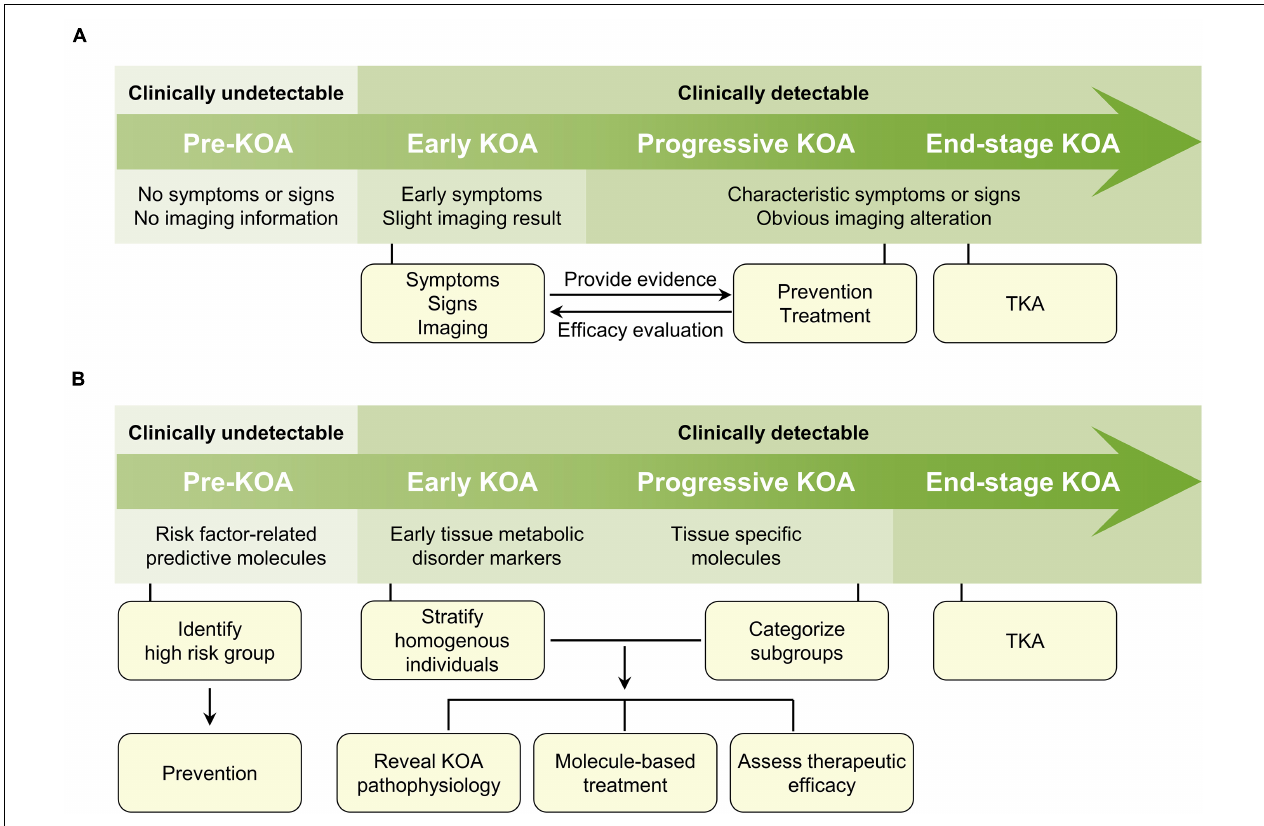
FIGURE 1 | Clinical information-based and molecule-based diagnosis and treatment algorithm of KOA. (A) In the clinical information-based KOA diagnosis and treatment algorithm, there is no symptoms, signs, and imaging information for pre-KOA. In early KOA, early symptoms and mild imaging results can be acquired. In progressive and late-stage KOA, the diagnosis is comparatively easy due to obvious clinical manifestations. Treatment decision making principally depends on clinical appearances and in turn, the evaluation of therapeutic efficacy is largely based on clinical outcomes. (B) In the molecule-based KOA diagnosis and treatment algorithm, the detection of KOA risk factors-related molecules in body fluids provides opportunity for the prediction of high-risk KOA individuals, and subsequently the preventive strategies. Although clinical information in early and progressive stage are acquirable, disease corresponding molecules permit the stratification of homogenous individuals and the classification of KOA into several subtypes. The molecular classification of KOA may help to reveal the pathogenesis of KOA, explore the molecule-based treatment, and further assess the therapeutic efficacy of treatment. For end-stage KOA, TKA might still be the best option. KOA, knee osteoarthritis; TKA, total knee